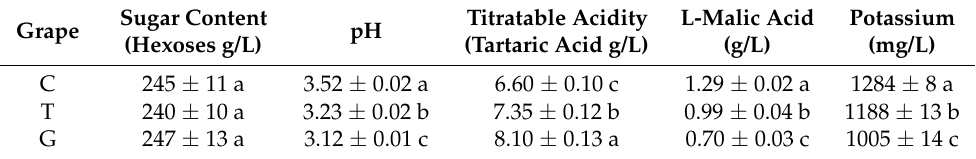
Table 1. Chemical parameters of the grapes at harvest subject of the experimentation. C = Castellina, G = Gaiole, and T =